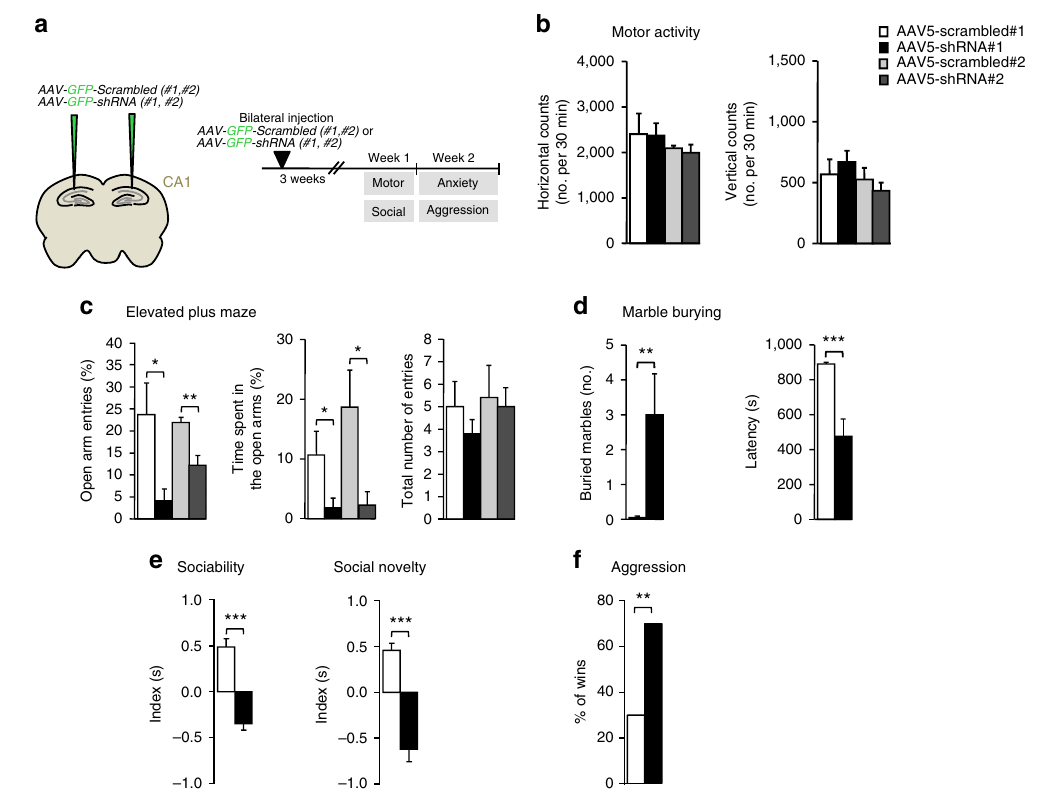
Figure 6 | Shrm4 silencing in vivo increases anxiety and impaired social behaviours. ( a ) Experimental design for investigating behavioural effects of Shrm4 silencing in rat hippocampal CA1. Rats were injected bilaterally with either AAV5-scrambled#1 (or #2) or AAV5-shRNA#1 (or #2) and tested after 3 weeks. ( b ) No change in motor function in terms of total number of counts evaluated in an automated activity cage for 30 min between Shrm4 knockdown or control animals. ( c ) A reduced number of open-arm entries and time spent in the open arms for Shrm4 knockdown; no difference in the total number of entries (open-arm entries: Scrambled#1 versus shRNA#1: n ¼ 12, 8; * P ¼ 0.045; t -test; Scrambled#2 versus shRNA#2: n ¼ 5, 5; ** P ¼ 0.005; t -test) (time spent in the open arms: Scrambled#1 versus shRNA#1: n ¼ 8, 8; * P ¼ 0.0307; t -test; Scrambled#2 versus shRNA#2: n ¼ 8, 8; * P ¼ 0.0133; t -test). ( d ) An increased number of marbles buried and a decreased latency to the first burial were observed in knockdown animals (buried marbles: n ¼ 11, 10; ** P ¼ 0.008; t -test) (latency: n ¼ 10, 10; *** P ¼ 0.0003; t -test). ( e ) In the sociability and social novelty test, a reduced time close to stranger 1 in the sociability test and to stranger 2 in the social novelty test was observed in AAV5-shRNA#1 rats compared with AAV5-scrambled#1 rats; (Sociability: n ¼ 5, 5; *** P o 0.0001; t -test; social novelty: n ¼ 5, 5; *** P ¼ 0.0002; t -test). All histograms were presented as mean ± s.e.m. ( f ) Tube test—AAV5-shRNA#1 rats showed a greater aggression compared with AAV5-scrambled#1 rats. n ¼ 5; ** P ¼ 0.0041; Fisher’s exact probability